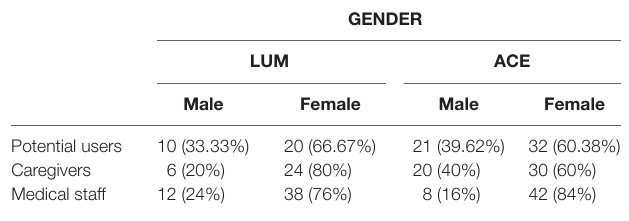
Table 1 | gender distribution (in %) in the tested